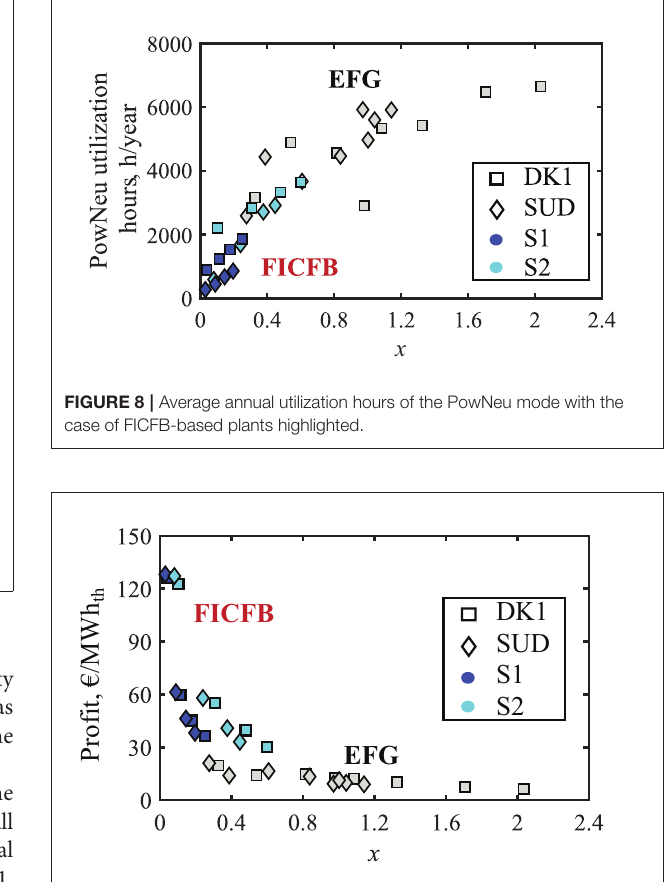
FIGURE 9 | Maximum profit of W2G plants under different